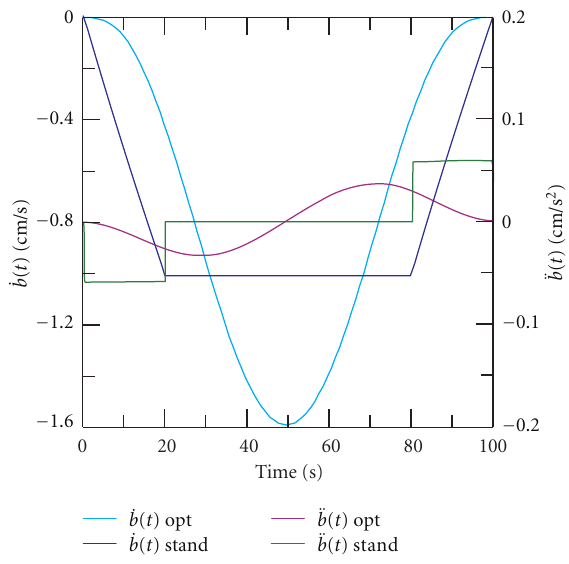
Figure 8: Laws of deployment.